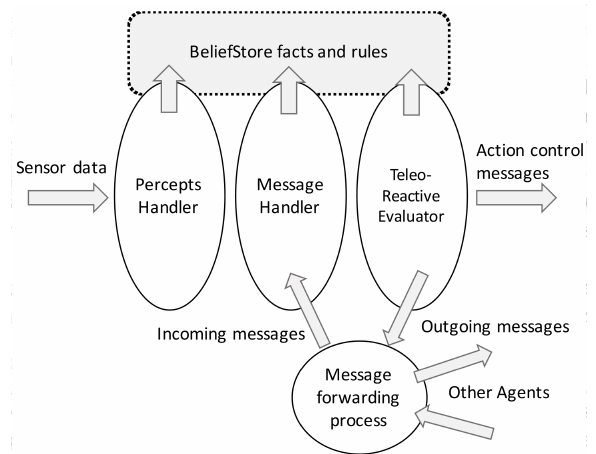
Figure 1. Multi-threaded TeleoR architecture (taken from